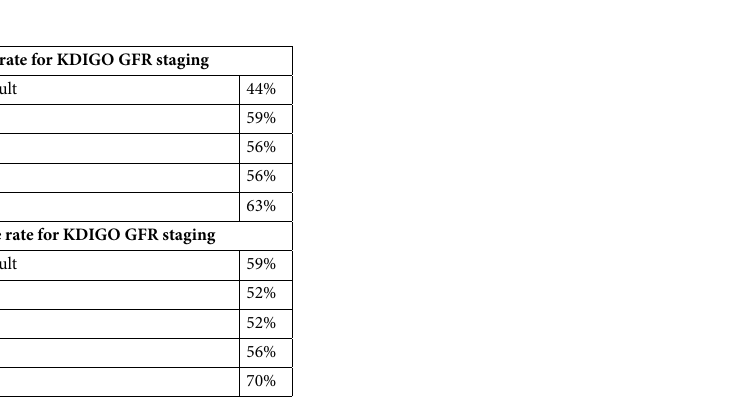
Figure 3. Scatter plot showing the relationship between eGFR and mGFR values (( A ) preoperative values; ( B ) postoperative values).